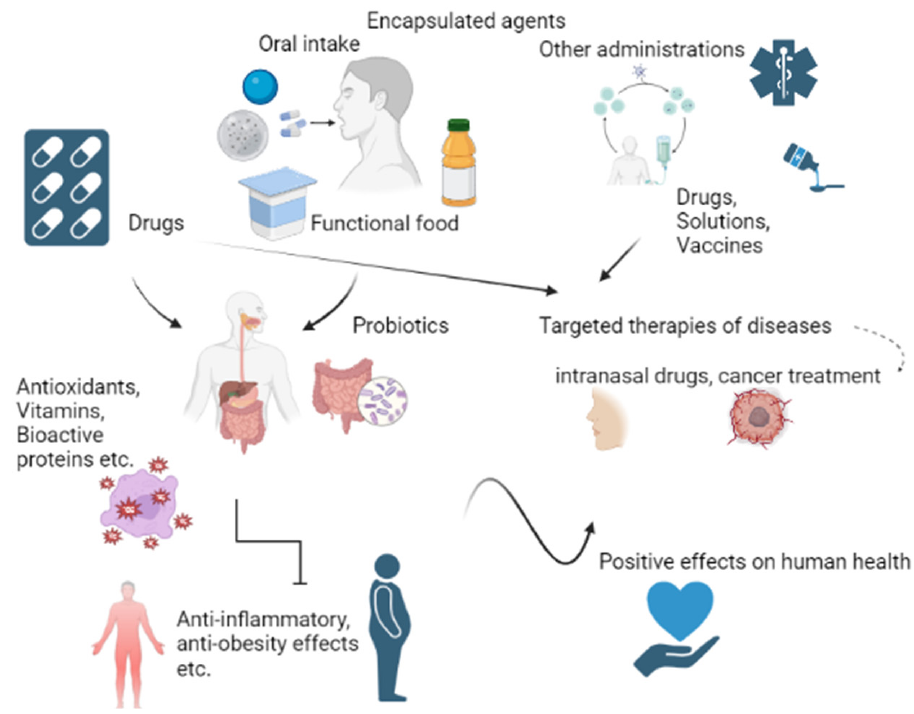
Figure 1. Overview of encapsulation uses.